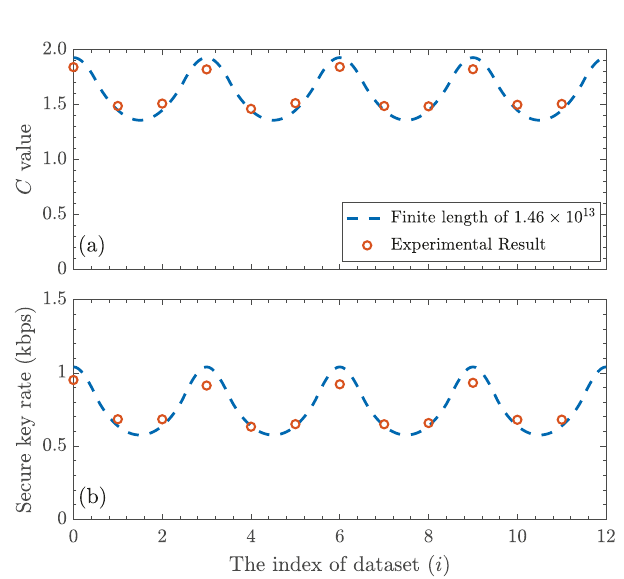
Fig. 4 The C value, secure key rate of the merged datasets and the simulated result with N t = 1.46 × 10 13 and m = 12. a and b show the C value and secure key rate respectively. The C value and secure key rate varies corresponding to varying misalignment of reference frame leaks different amounts of secure key information 22 .